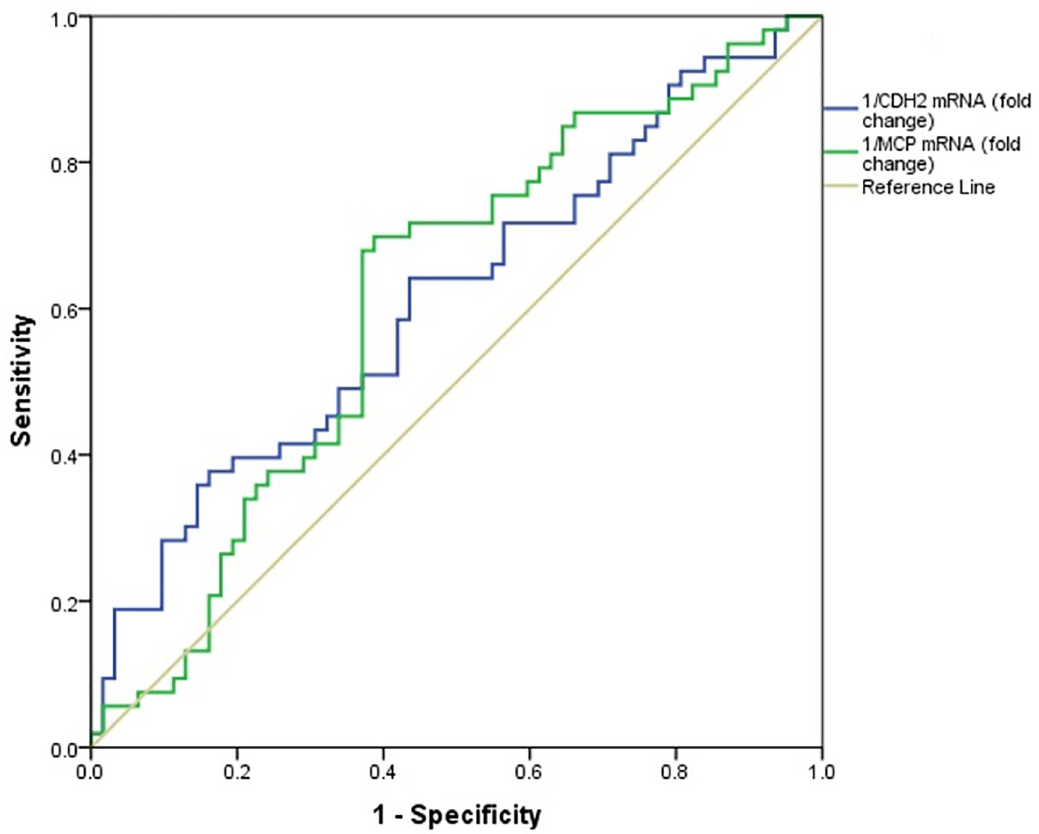
Fig 4. The receiver operating characteristic (ROC) analyses of 1/CDH2 mRNA and 1/MCP-1 mRNA to differentiate incipient DN patients from DM patients.